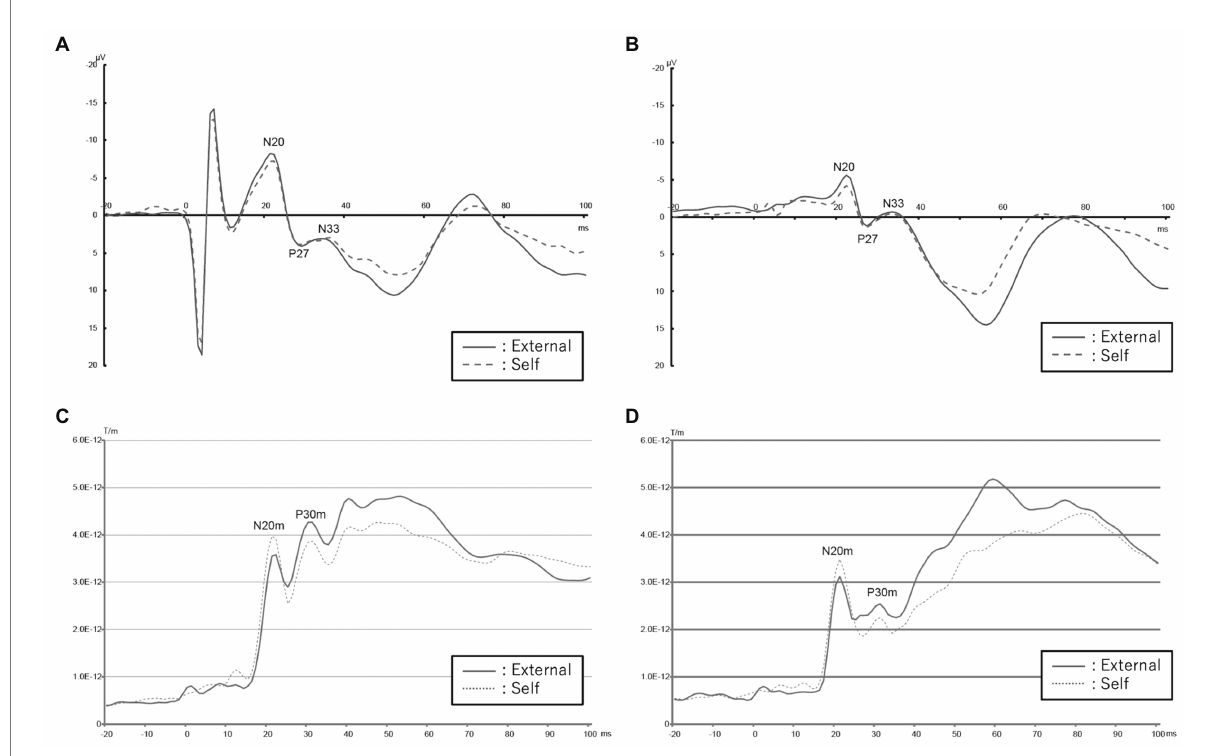
FIGURE 1 EEG and MEG data acquired from patients with schizophrenia compared to healthy controls in the self and external conditions. (A) Mean EEG waveform in healthy controls. Red colored solid line shows external condition and blue colored dashed one shows self-condition. (B) Mean EEG waveform in patients with schizophrenia. Red colored solid line shows external condition and blue colored dashed one shows self-condition. (C) Root mean square of SEF values of control group. Blue line indicates external condition and red indicates self-condition. (D) Root mean square of SEF values of schizophrenia group. Blue line indicates external condition and red indicates